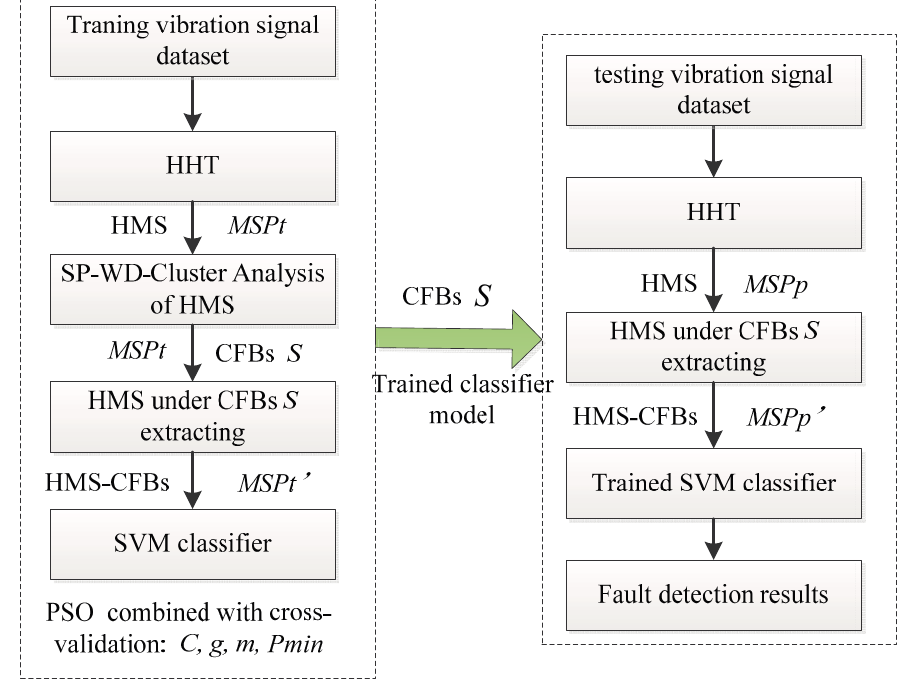
Figure 1. The procedure for the HHT-WMSC-SVM REBs fault detection